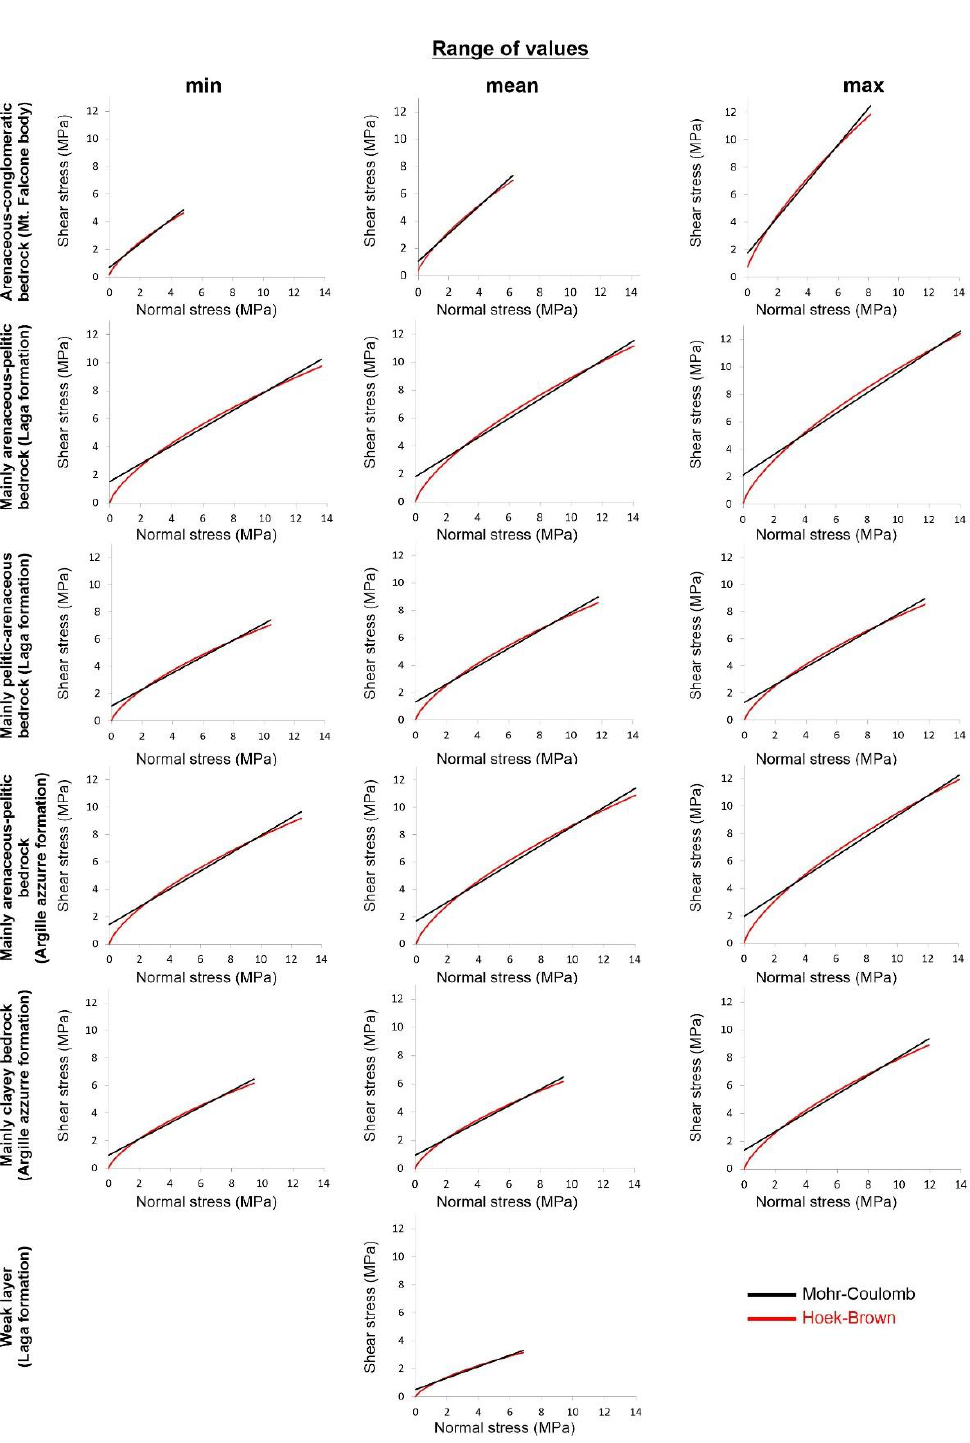
Figure 7. Shear vs. normal stress plots of Hoek–Brown and Mohr–Coulomb failure envelopes, obtained for each litho- technical unit and different range of values. A shear vs. normal stress plot was obtained for each bedrock unit and for each class of values (min, mean and max). ment of numerical models for each geotechnical